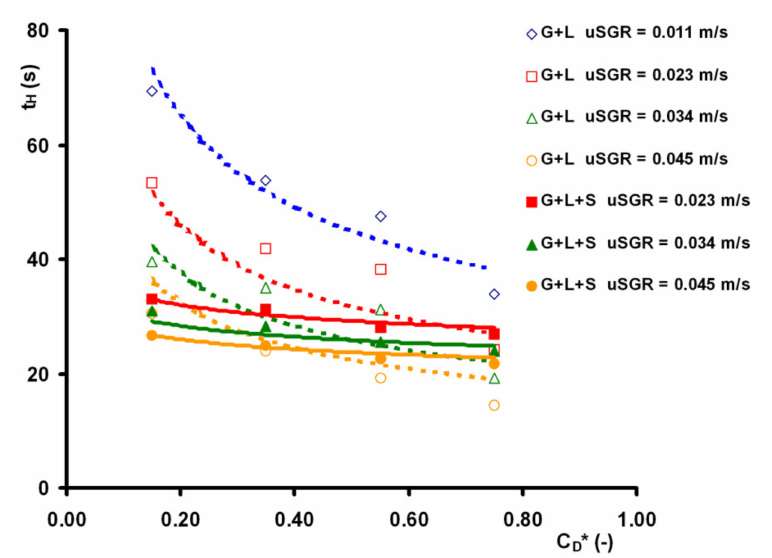
Figure 4. Homogenization time t H : Effect of dimensionless deflector clearance: Gas–liquid system (empty symbols), gas–liquid–solid system (full symbols), correlation (6) for gas–liquid system (dotted line), correlation (6) for gas–liquid–solid system (full